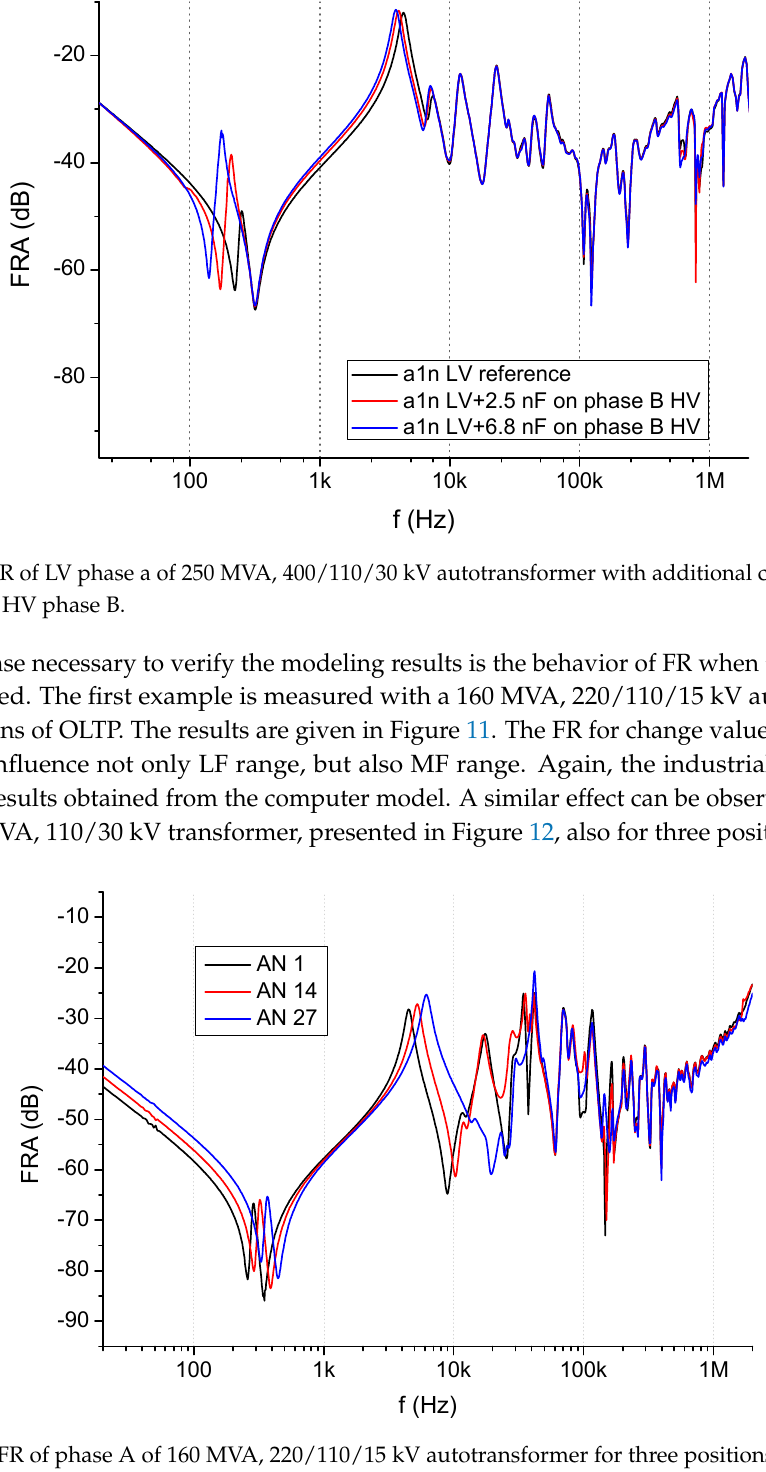
AN 27 Figure 12. FR of phase A of 31.5 MVA, 110/30 kV transformer for three positions of OLTC. The abovementioned results show that the influence of inductance changes can be observed in the wide frequency range, including LF. If this is the only cause of changed FR measurement, it should be easy to detect. However, if these results were to be combined with capacitance changes, such as for modeling results shown in Figures 7 and 8, the outcome would be difficult to properly interpret. Such a transformer would possibly be described as faulty, while visible changes may be the result of the wrong tap position combined with some capacitive changes on the bushing of different phases than those measured. Yet another problem is core magnetization, which influences only LF range. An example of such a measurement is given in Figure 13.